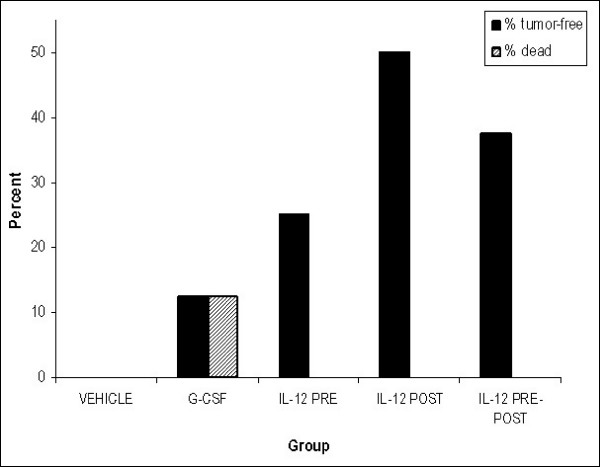
Percentage of mice in the vehicle, G-CSF, IL-12 pre-only, IL-12 post-only and IL-12 pre-post treatment groups that were tumor-free following the second round of cyclophosphamide treatment. The percentage of mice in the lymphoma study that remained tumor-free at the end of the second round of cyclophosphamide (225 mg/kg), which was 5 weeks from the first round of cyclophosphamide treatment and 7 weeks after tumor inoculation. No mice in the vehicle groups were tumor-free. There was one death in the G-CSF treatment group.